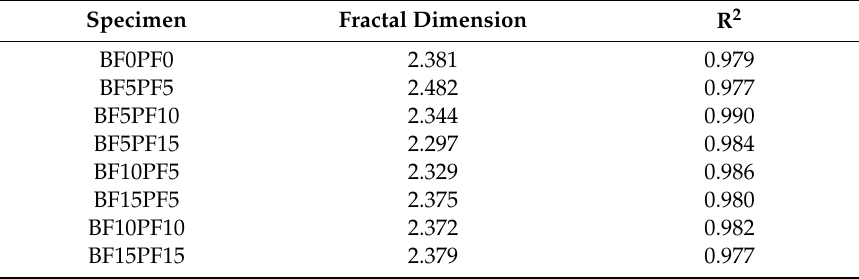
Figure 6. Double logarithmic scatter plot of conversions number with pore and diameter. Table 5. Results of the fractal dimension.